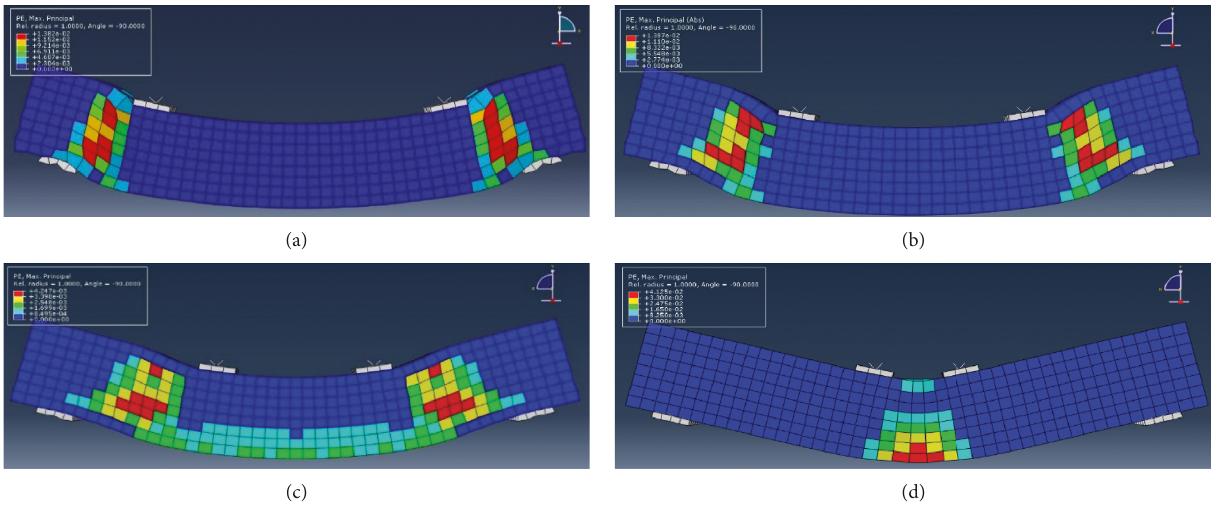
Figure 12: Failure modes of the control beams with different a/d ratios between 1 and 2.5. (a) a/d � 1. (b) a/d � 1.5. (c) a/d � 2. (d) a/d �